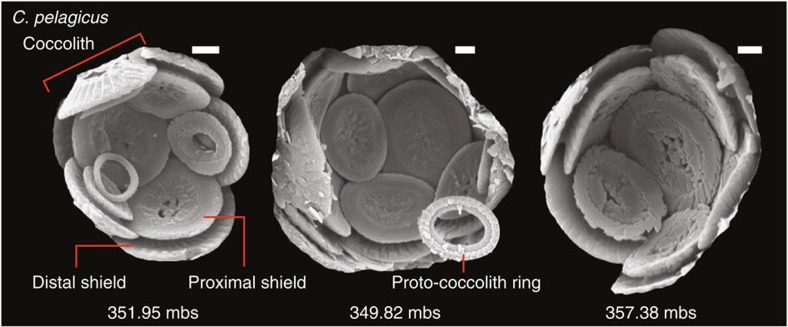
Scanning electron micrographs of C. pelagicus at Bass River, New Jersey.Sample depths are 351.95, 349.82 and 357.38 mbs as indicated. The minimum in size-normalized thickness of C. pelagicus occurs between 357.38 and 357.36 mbs. Individual scale bars indicate 1 μm.